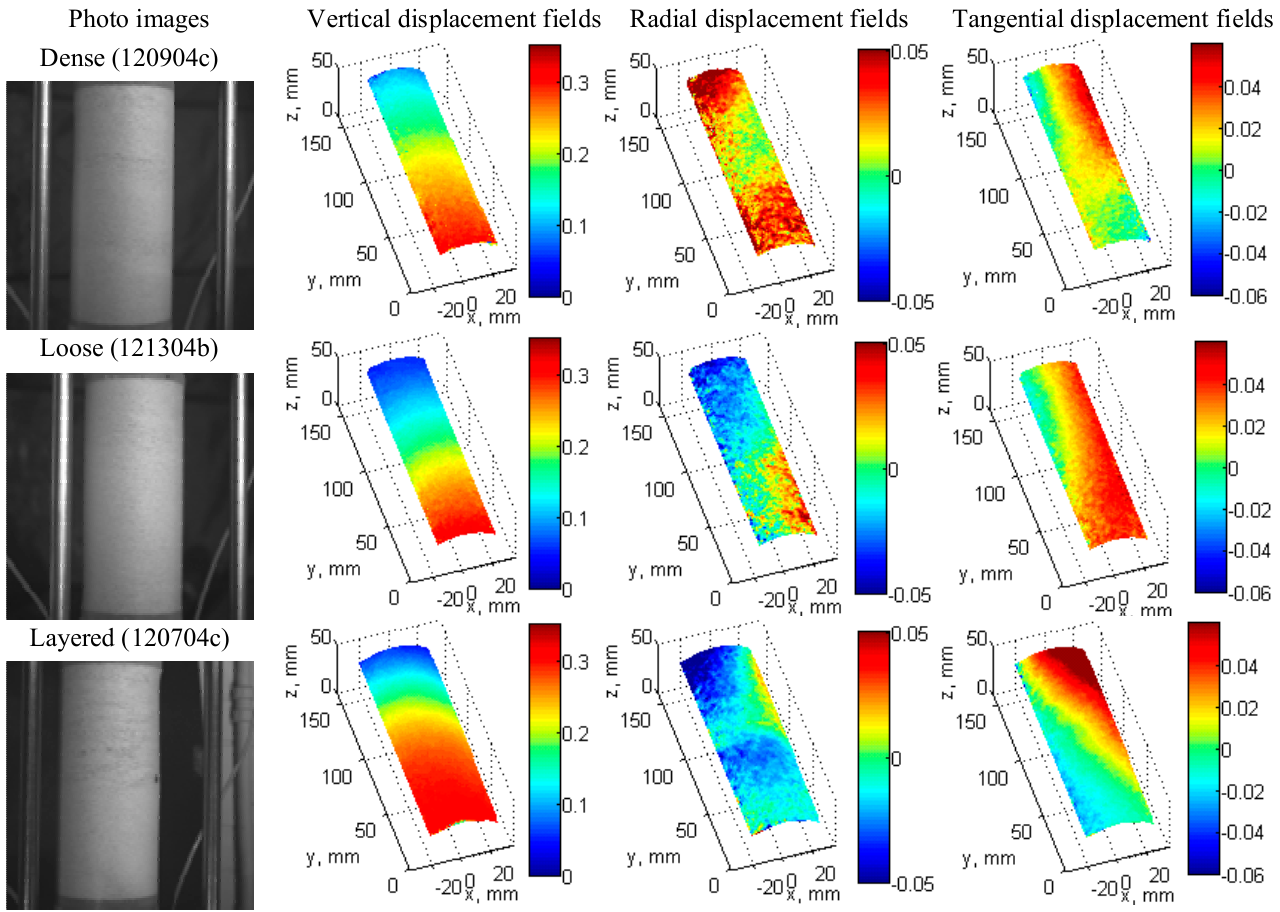
Figure 3. Photo images and cumulative displacement fields in mm at 0.2% of axial strain, representing the elastic state.